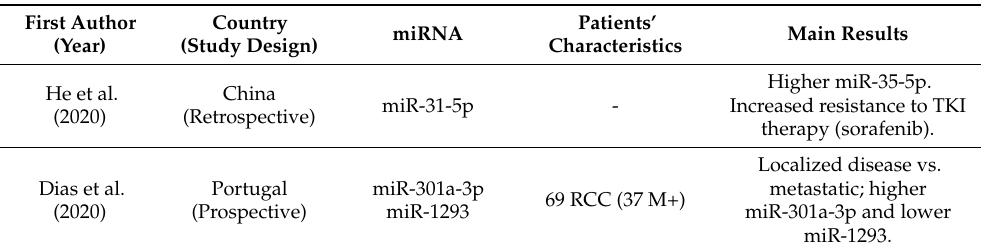
Table 2. The main characteristics of studies investigating the effect of exosomal miRNAs in patients diagnosed with renal cell